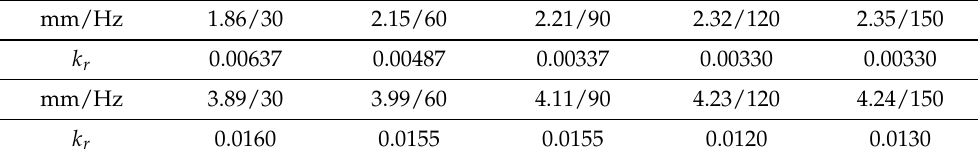
Table 3. Experimental k r values for various frequencies and average air